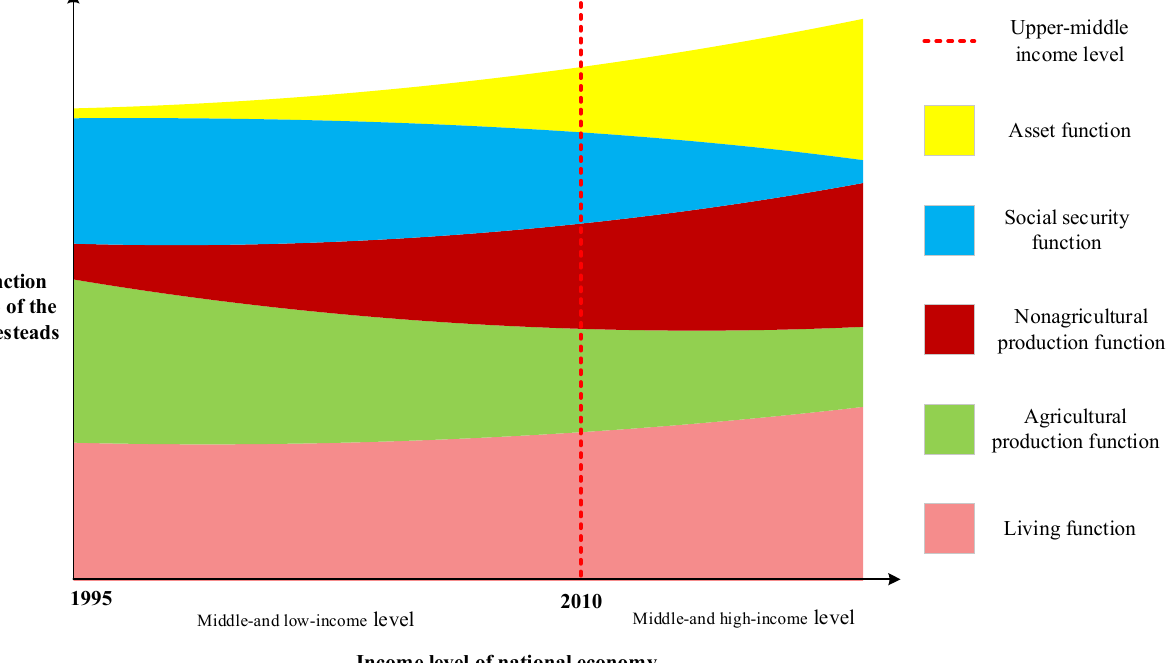
Figure 7. Evolutionary Trend in Homestead Function under the Background of Economic Develop- ment.